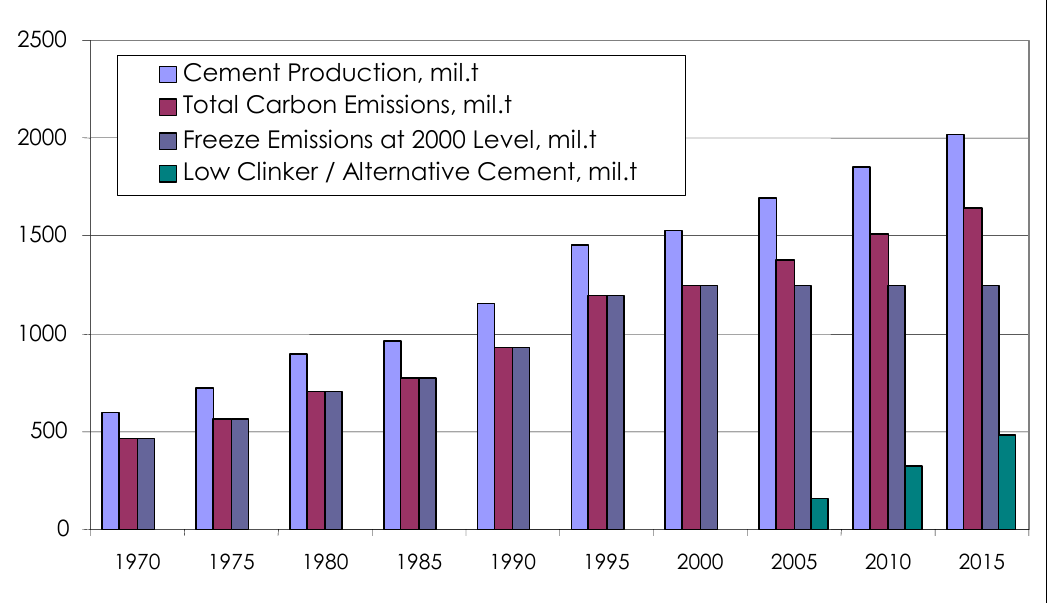
FIGURE 4 . Prediction of emissions and market share of low-clinker